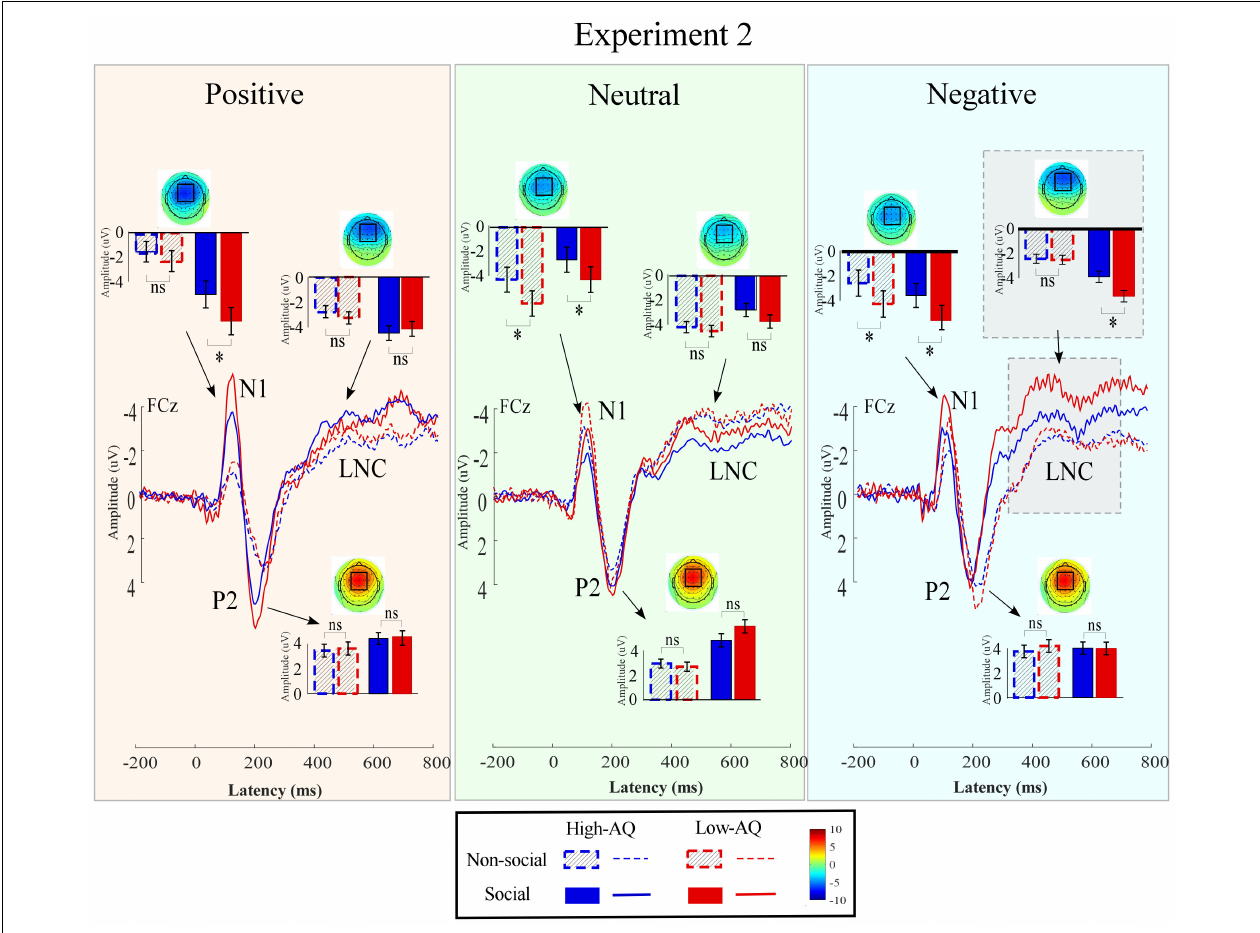
FIGURE 7 | Event-related potentials waveforms, scalp topography distributions, and bar charts in Experiment 2. ERP waveforms were exhibited by the High-AQ (blue) and Low-AQ (red) groups passively listening to positively (left column) , neutral (middle column) , and negatively (right column) valenced audio recordings with social (solid) or non-social (dotted) dimensions. Electrodes used to estimate the mean ERP amplitudes were marked using the black squares on their respective topographic distributions. Data in the bar charts were expressed as Mean ± SEM. ns p > 0.05, * p < 0.05, ** p < 0.01, *** p < 0.001.